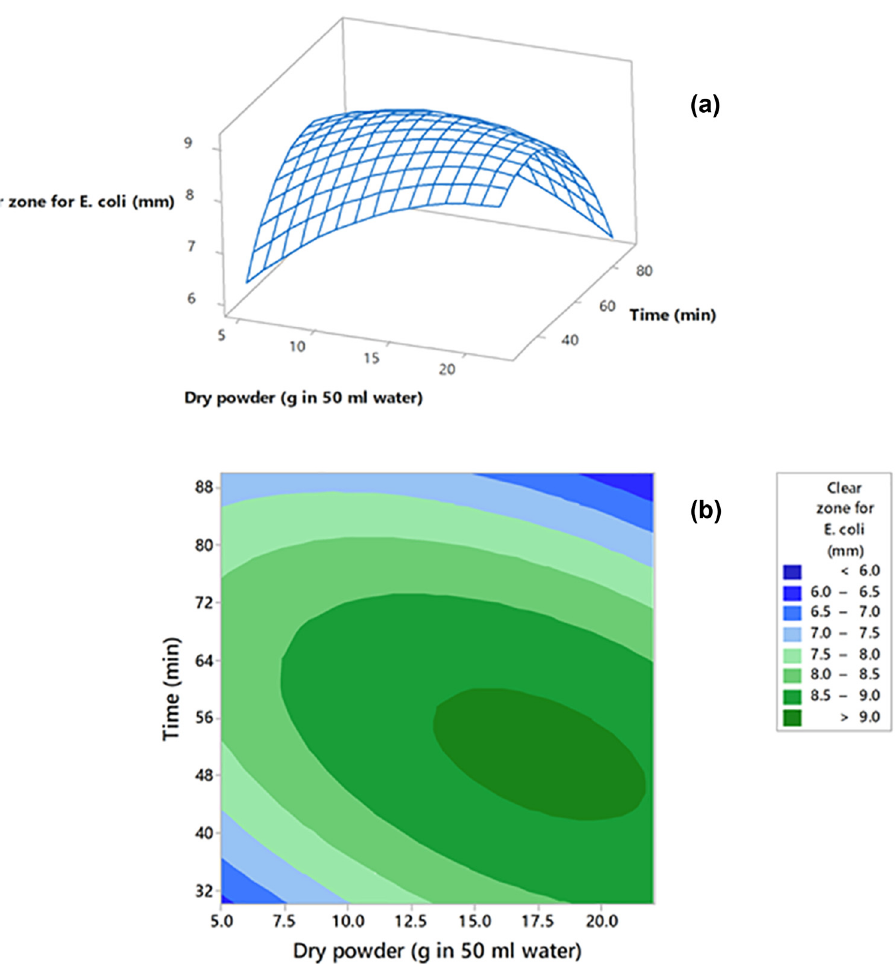
Figure 6: Response surface ( a ) and contour plots ( b ) for the antibacterial activity of ZnO NPs as function of signi fi cant ( p < 0.05 ) interaction e ff ects of reaction time and amount of dried